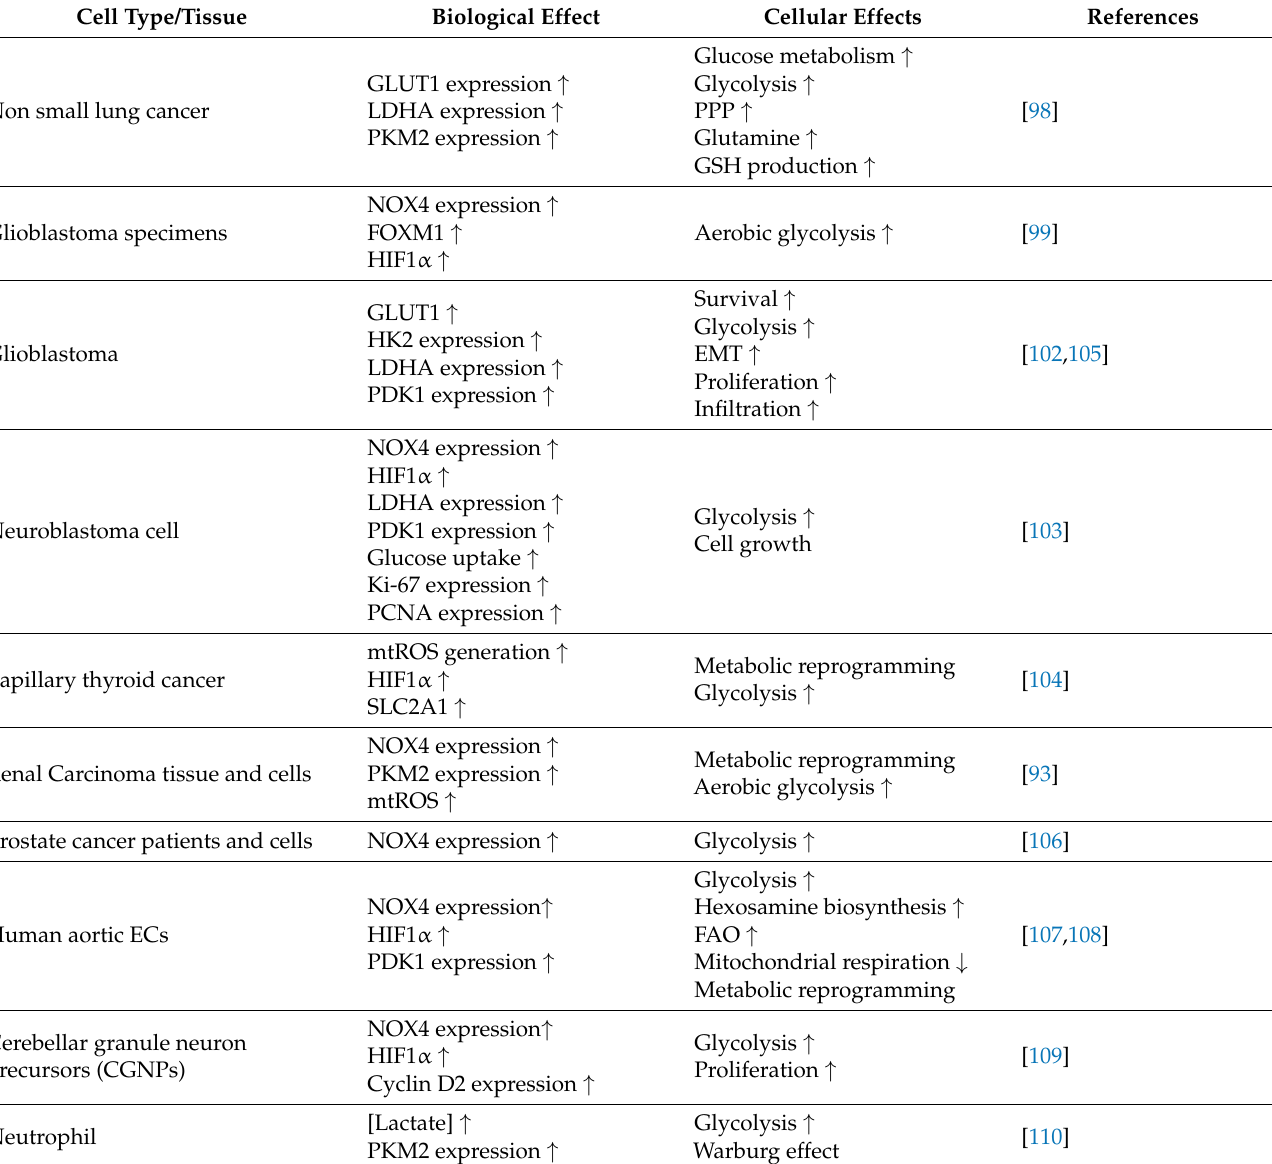
Table 3. NOX4 implication in cell metabolism